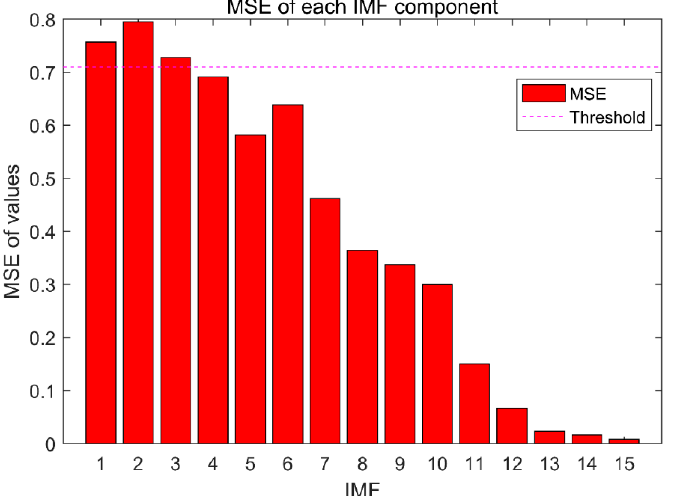
Figure 17. MSE value of each component of vibration signal decomposed by CEEMD.